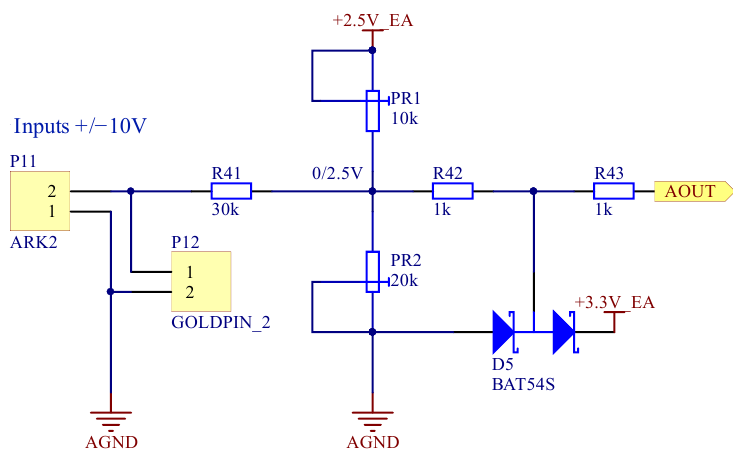
Figure 1. Schematic of a single ± 10 V analog